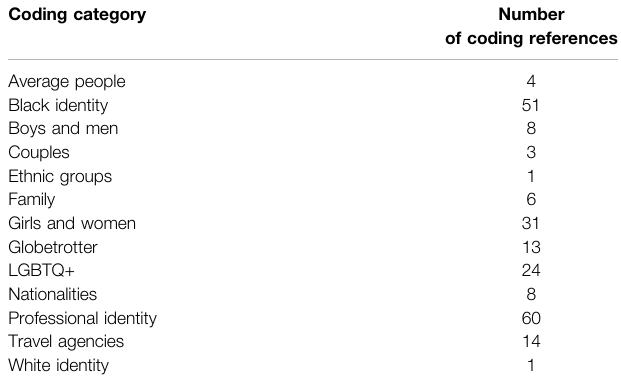
TABLE 4 | Insta- and -gram hashtags in the data. Hashtags beginning with insta-